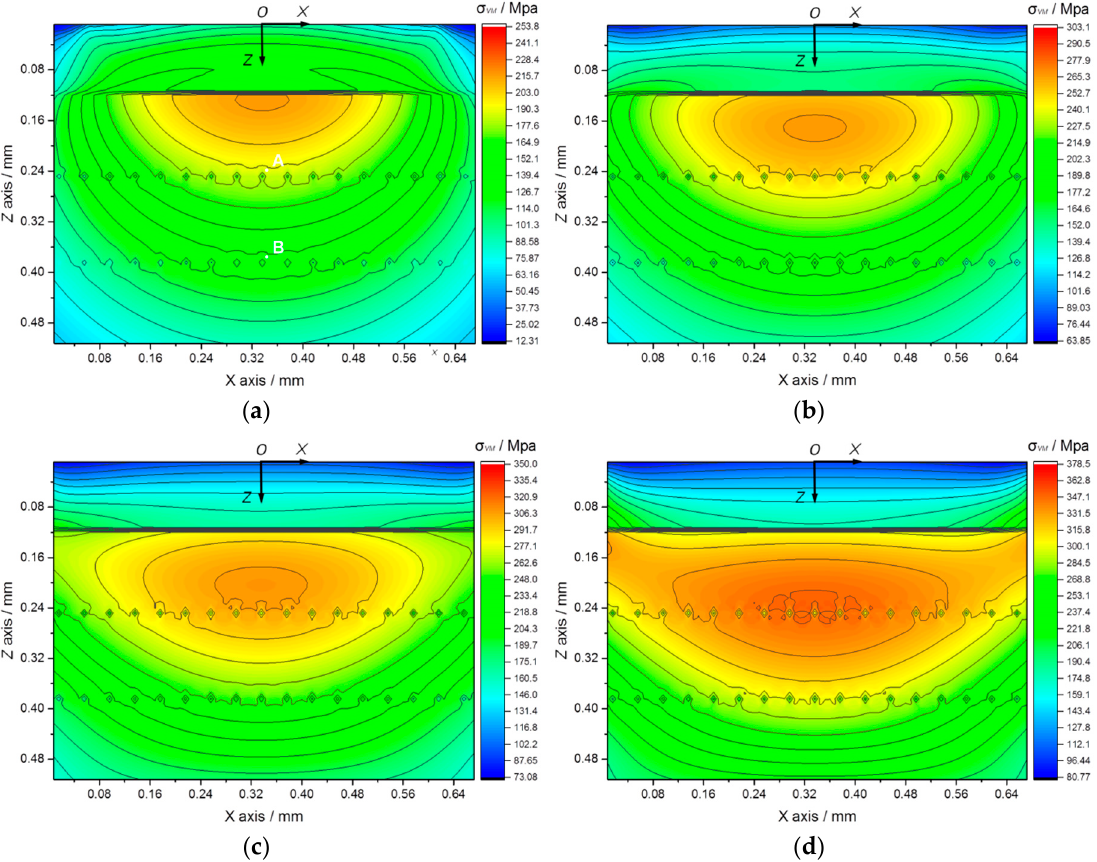
Figure 15. Von Mises stress field evolution in cross-section XOZ of the Ti-(SiC f /Al 3 Ti)-laminated composite with increasing loads: ( a ) 0.4 kN, ( b ) 0.8 kN, ( c ) 1.2 kN, and ( d ) 1.6 kN.